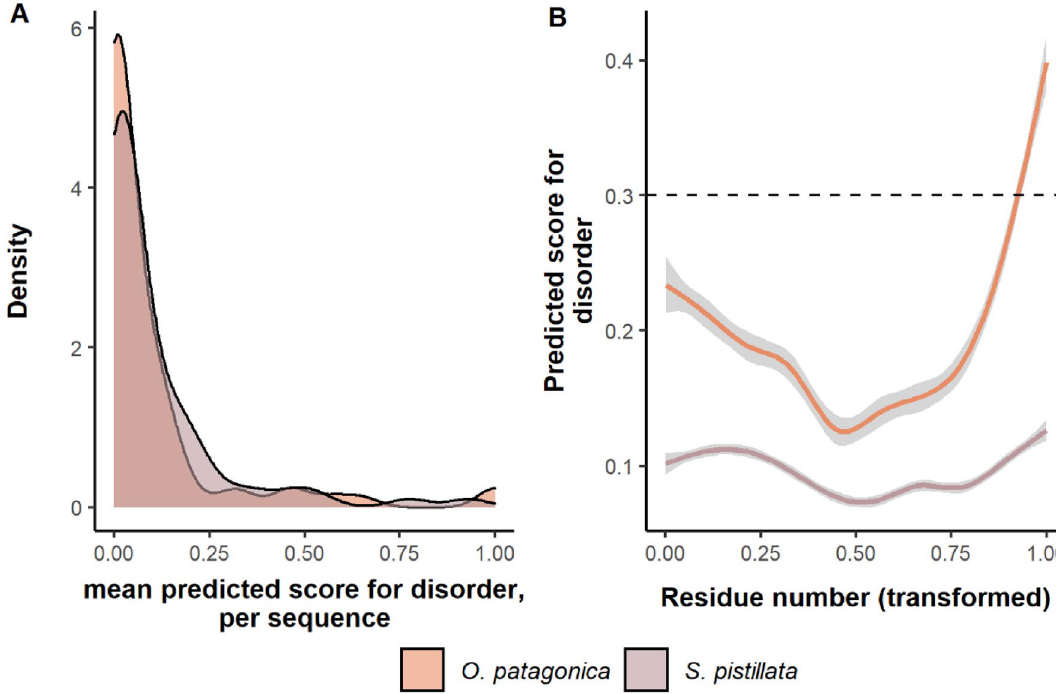
Figure 4. Prediction of intrinsically disordered regions. ( A ) A density plot displaying the sequences’ disorder mean predicted score per species. ( B ) The average (± standard error in grey) of the disordered score per residue across SOM proteins with at least a single region predicted to be disordered. The residue number is represented as the percentage of the entire sequence. Regions with a score above the dotted line are predicted to be disordered.